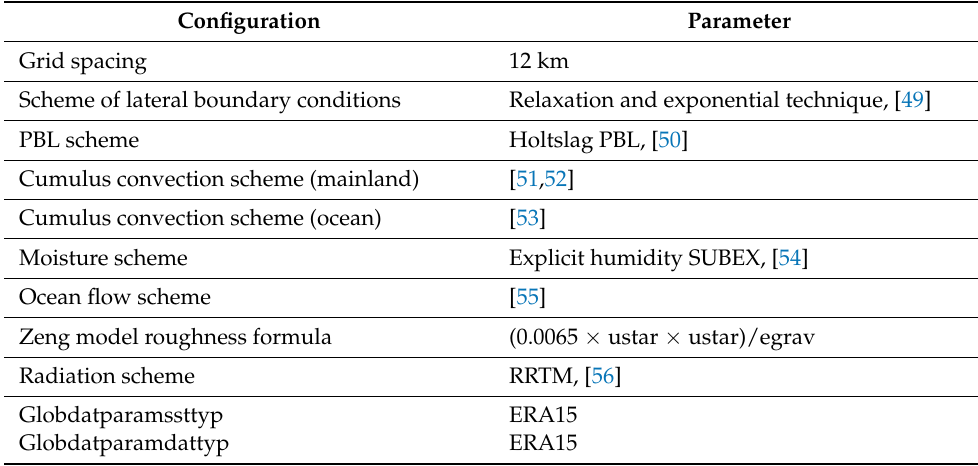
Table 1. Parameters used in the physics of the RegCM